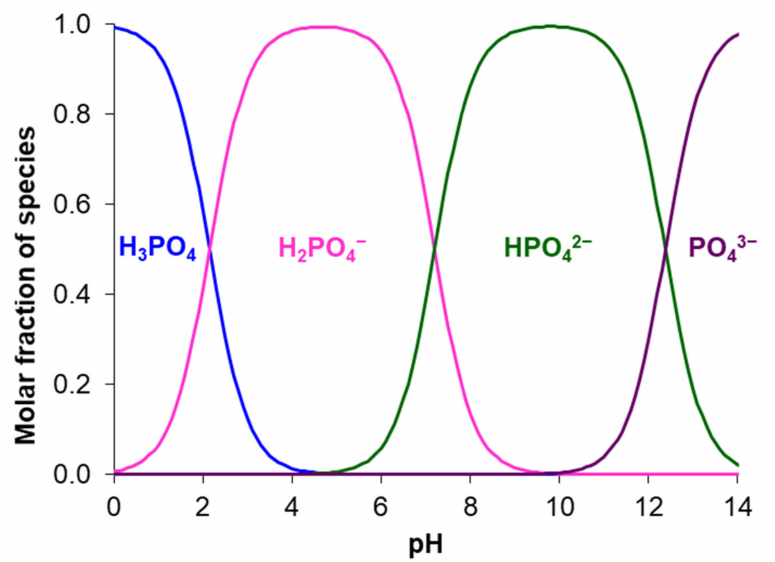
Figure 17. Distribution of mole fractions of phosphoric acid species depending on aqueous solution pH. Reproduced from [207].